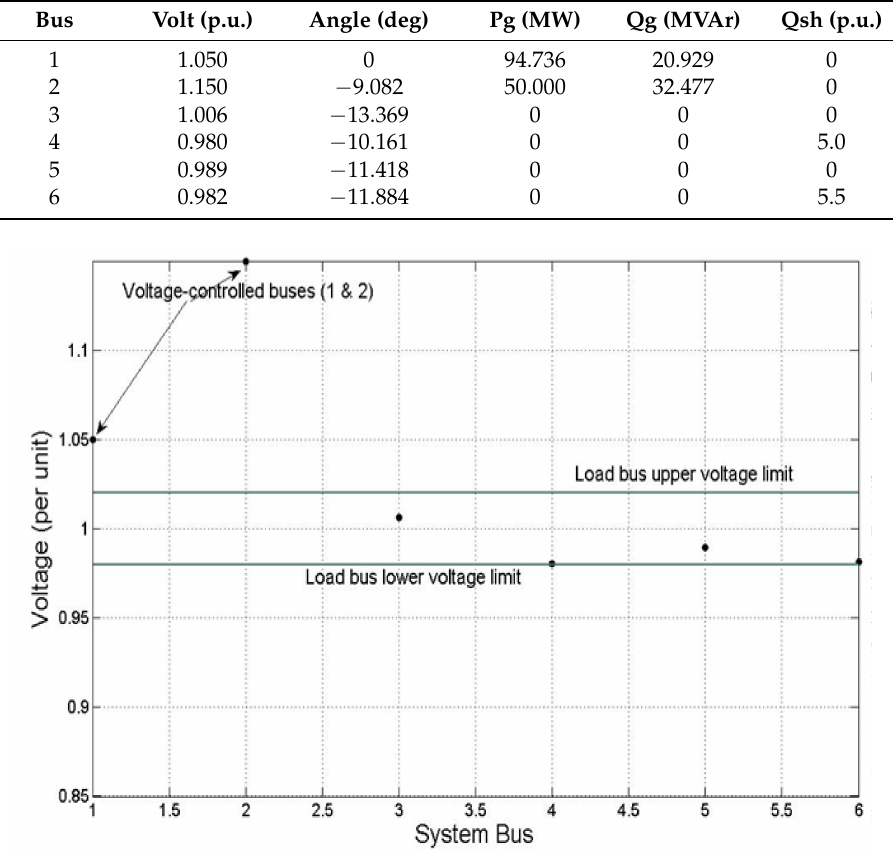
Figure 5. The 6-bus equilibrium voltage profile after